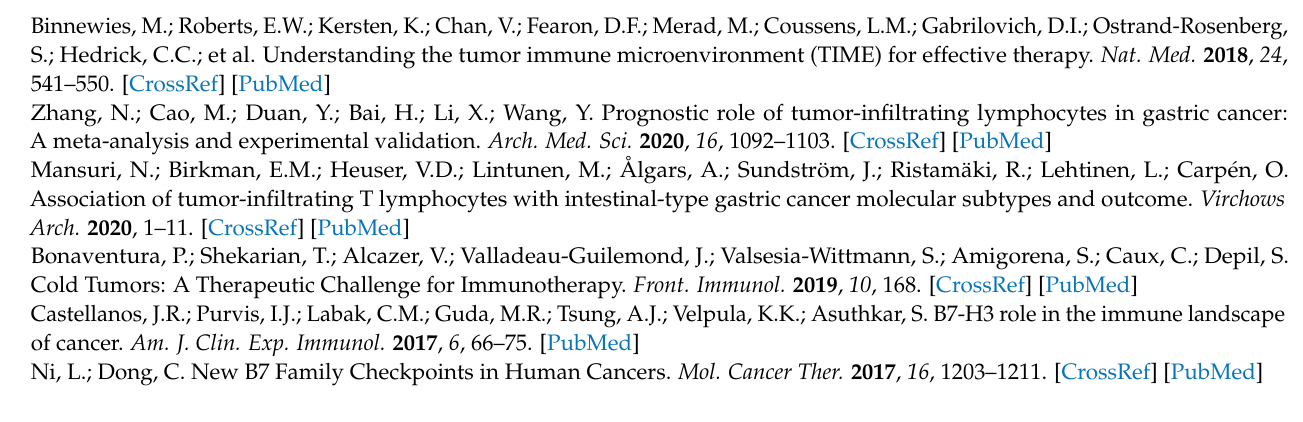
Figure S2 : Relevance of B7-H3 expression to CD8+T cell